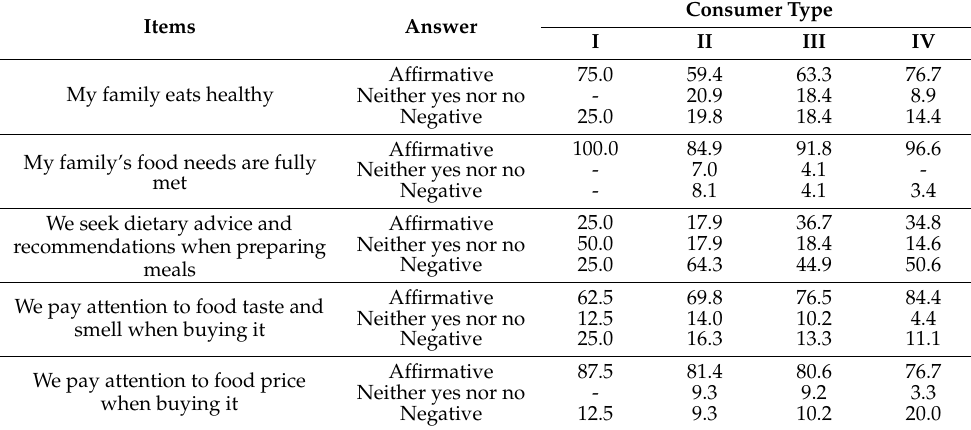
Table 9. Slovak consumers’ opinions on food and nutrition ( n = 300, in %).